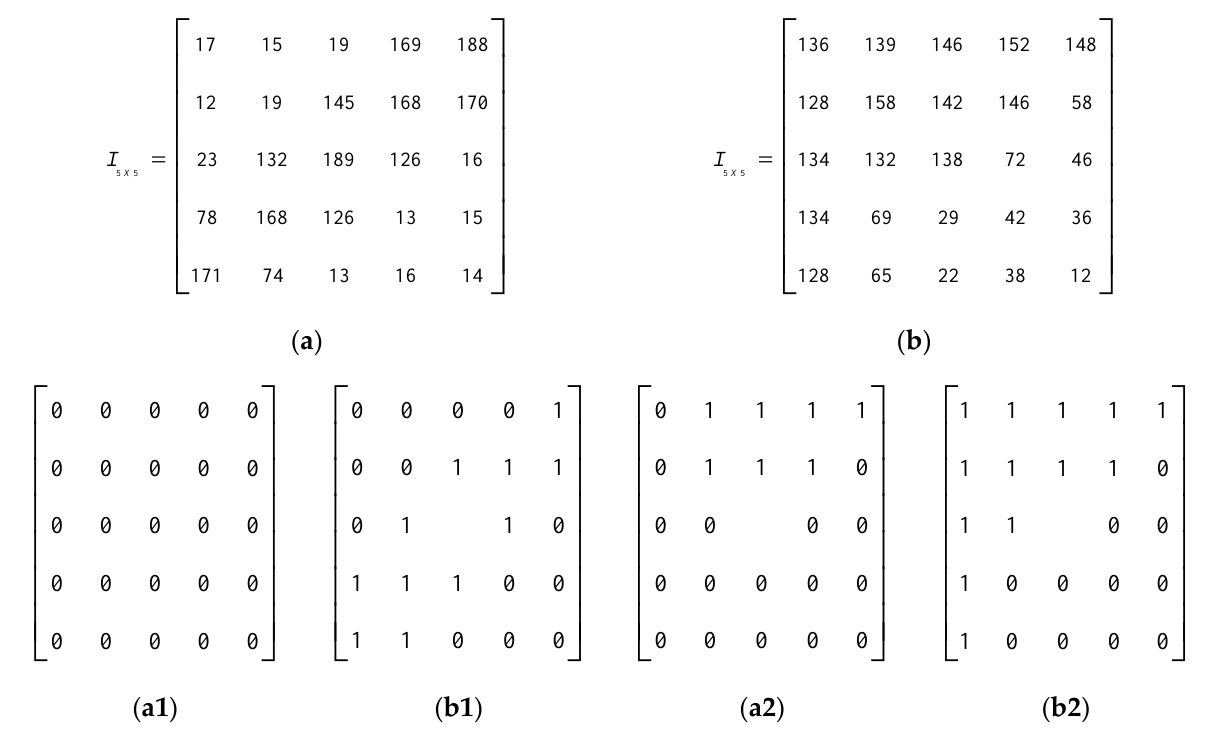
Figure 5. Example for effective edge preservation by proposed AvN-LBP. ( a , b ) Two image patches of size 5 × 5. ( a1 , b1 ) AvN-LBP preserves weak edge patterns. Two 5 × 5 example image patches are shown in ( a , b ). ( a1 , a2 ) are the patterns given by LBP for ( a , b ), respectively. ( b1 , b2 ) AvN-LBP patterns of ( a , b ), respectively.